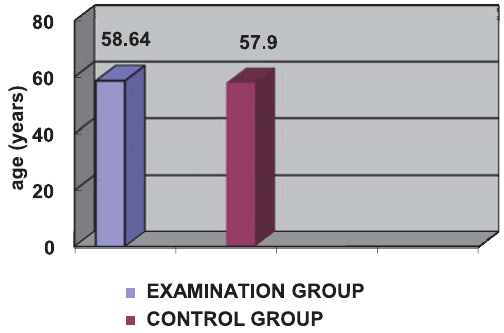
FIGURE 2. Average daily intake of dietary calcium among women without estrogen de fi ciency in menstrual history. p<